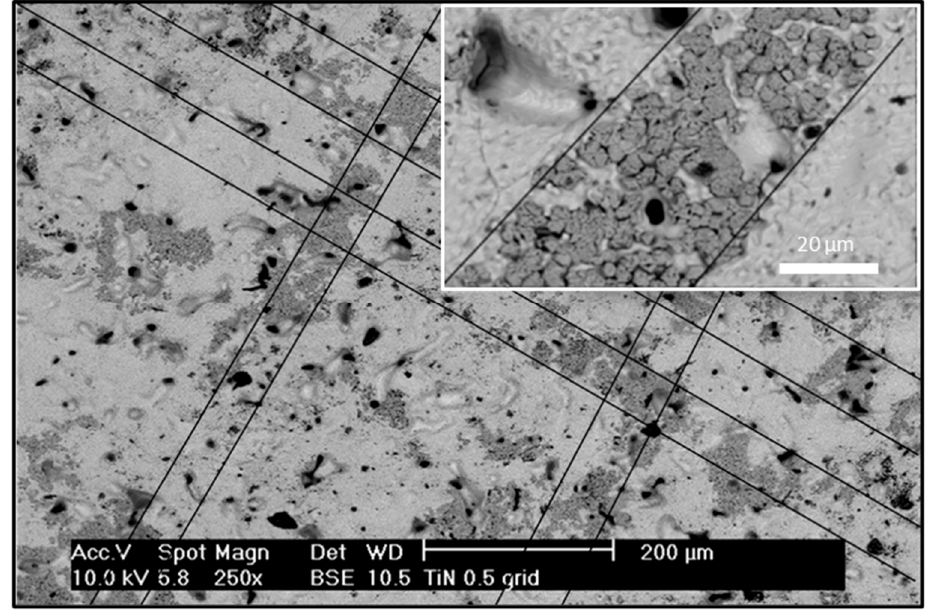
Figure 4. SEM image of the sample with the 0.5 mm grid after sintering at 1100 °C for 1 h in vacuum at two different magnitudes. Black lines show the distribution of the particles on the surface.